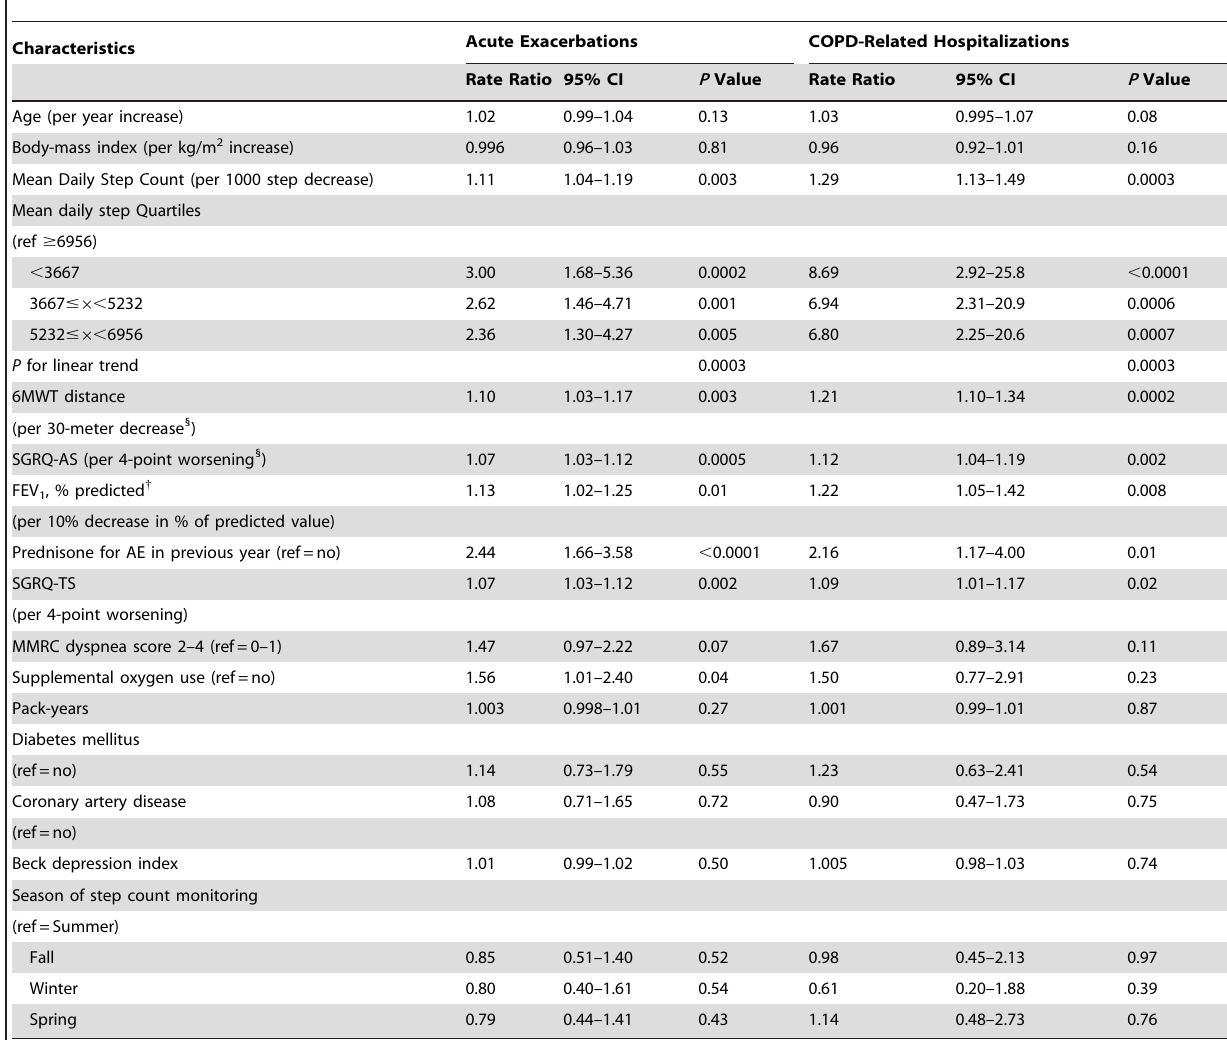
Table 2. Univariate Associations with Number of Acute Exacerbations and COPD-Related Hospitalizations.